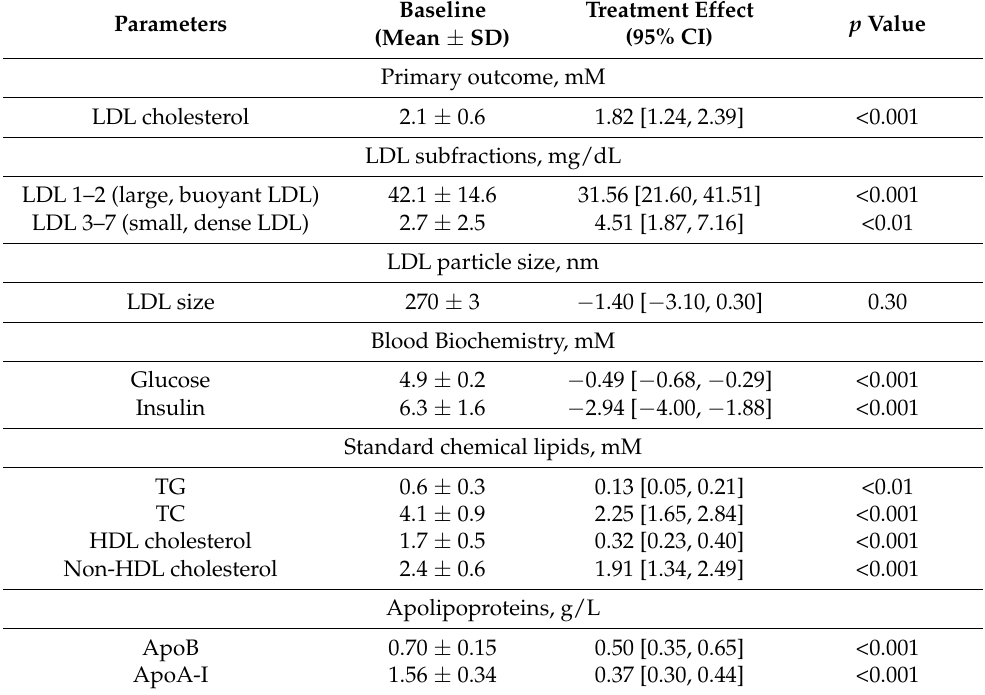
Table 2. Baseline measures (collected 2 to 5 days before starting the first diet intervention) and treatment effects of a four-week ketogenic LCHF diet 1